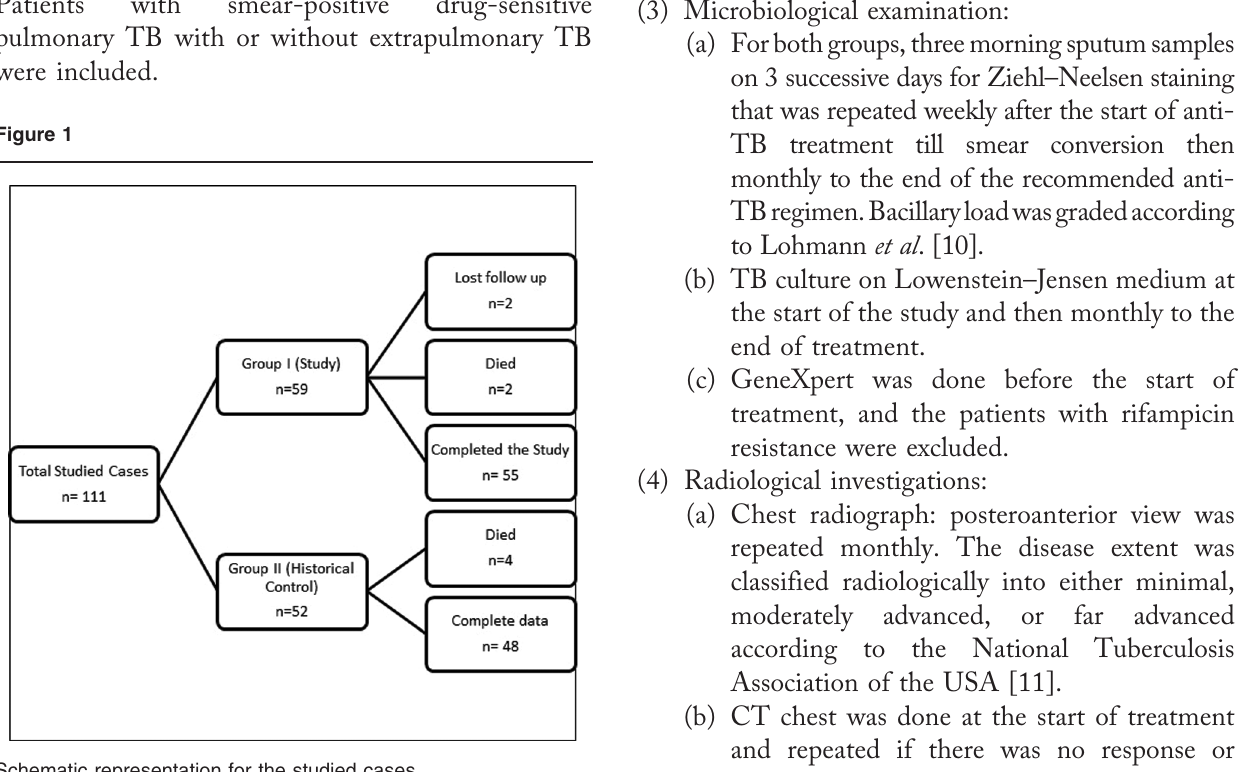
Schematic representation for the studied